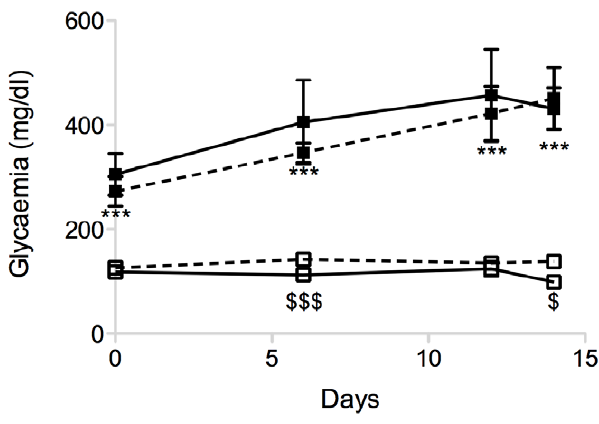
Figure 1. Blood glucose concentrations of SCID mice during the 2 weeks post-graft of chicken pancreas. Continious line, white square: control mice, n=12. Continious line, black square: STZ mice, n=7. Dotted line, white square: L1–10 treated control mice, n=5. Dotted line, black square: L1–10 treated STZ mice, n=5. Mice were used for grafting experiments between 3 to 5 days after STZ or citrate buffer injections. *** p , 0.001 control and L1–10 treated control mice vs STZ and L1–10 treated STZ mice. $ p , 0.05, $$$ p , 0.001 control mice vs: L1– 10 treated control mice.